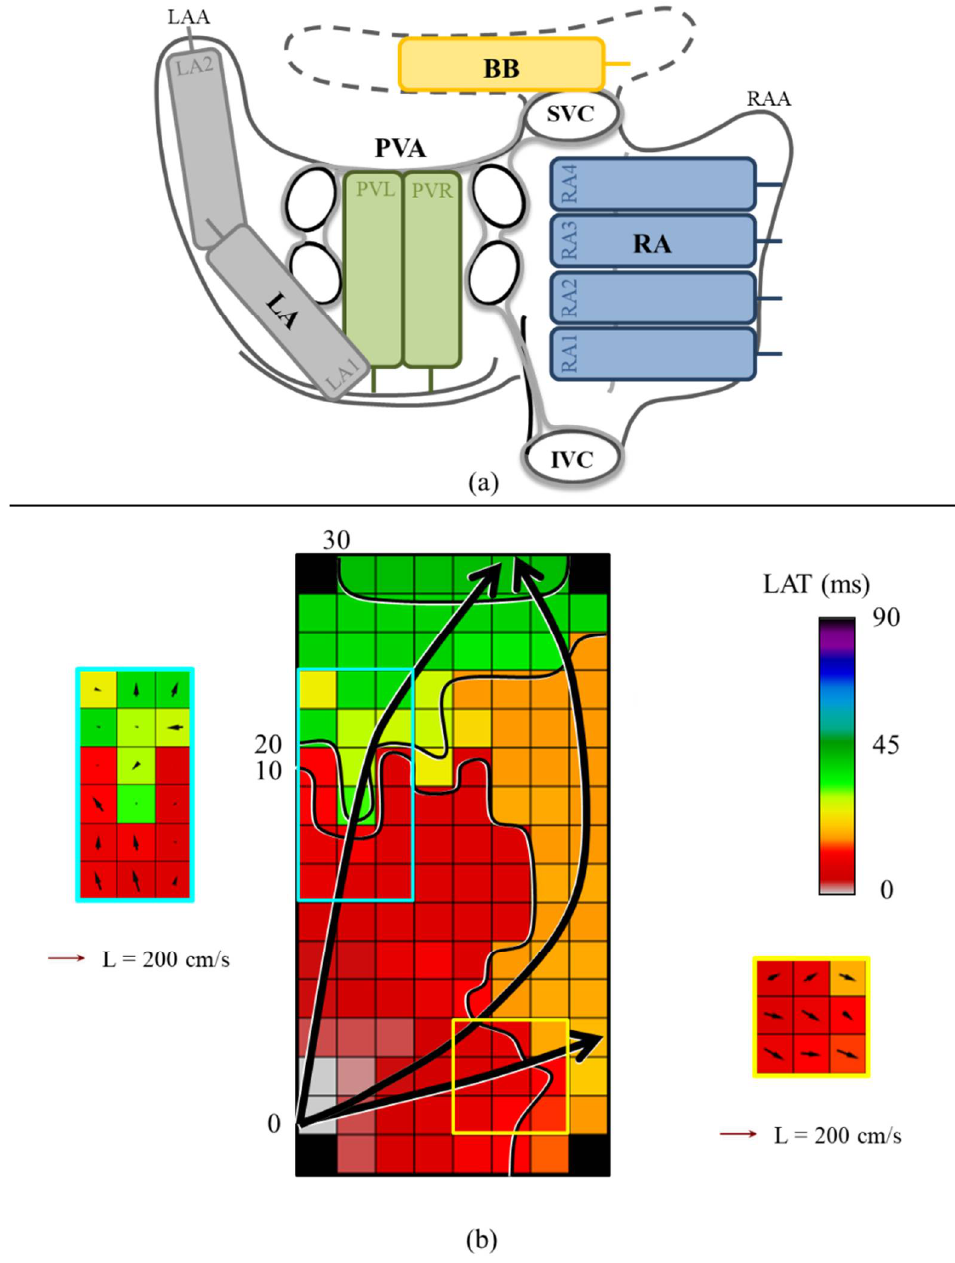
Figure 1. Method of epicardial mapping. ( a ) Mapping scheme on a schematic posterior view of the RA, BB, LA and PVA; ( b ) an example of a color-coded activation map with isochrones (black lines) drawn at 10 ms. The black arrow indicates the main wave direction. Examples of the corresponding CV map using discrete velocity vectors are shown next to the activation map. CV vectors are depicted per electrode. cm/s = centimeter/second; ms = milliseconds; BB = Bachmann’s Bundle; CT = conduction time; IVC = inferior vena cava; L = length; LA = left atrium; LAA = left atrial appendage; LAT = local activation time; PVA = pulmonary vein area; PVL = left pulmonary vein; PVR = right pulmonary vein; RA = right atrium; RAA = right atrial appendage; SVC = superior vena cava.